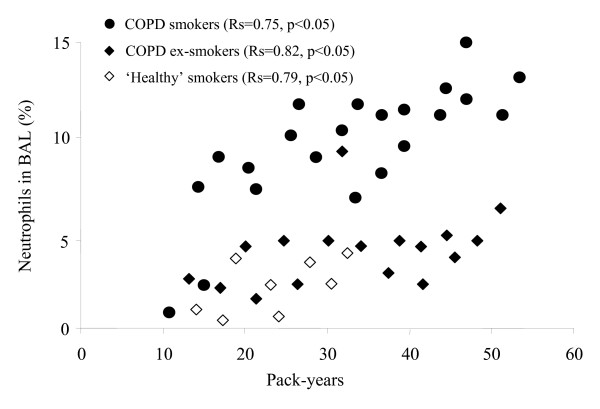
Smoking history and neutrophils. Correlation between smoking history (pack-years) and neutrophils (%) in BAL samples from COPD smokers, COPD ex-smokers and 'healthy' smokers.